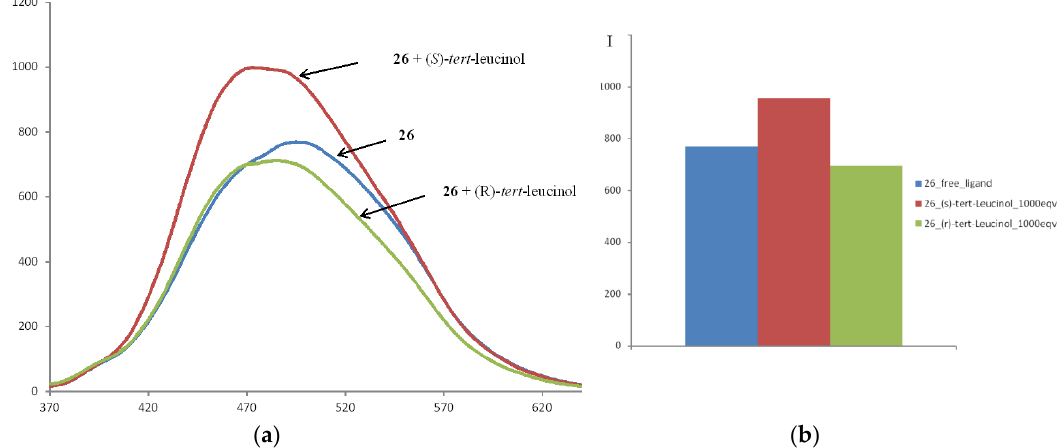
Figure 13. Fluorescence spectra of compound 25 in the presence of ( R )- and ( S )-enantiomers of leucinol (1000 equiv.).